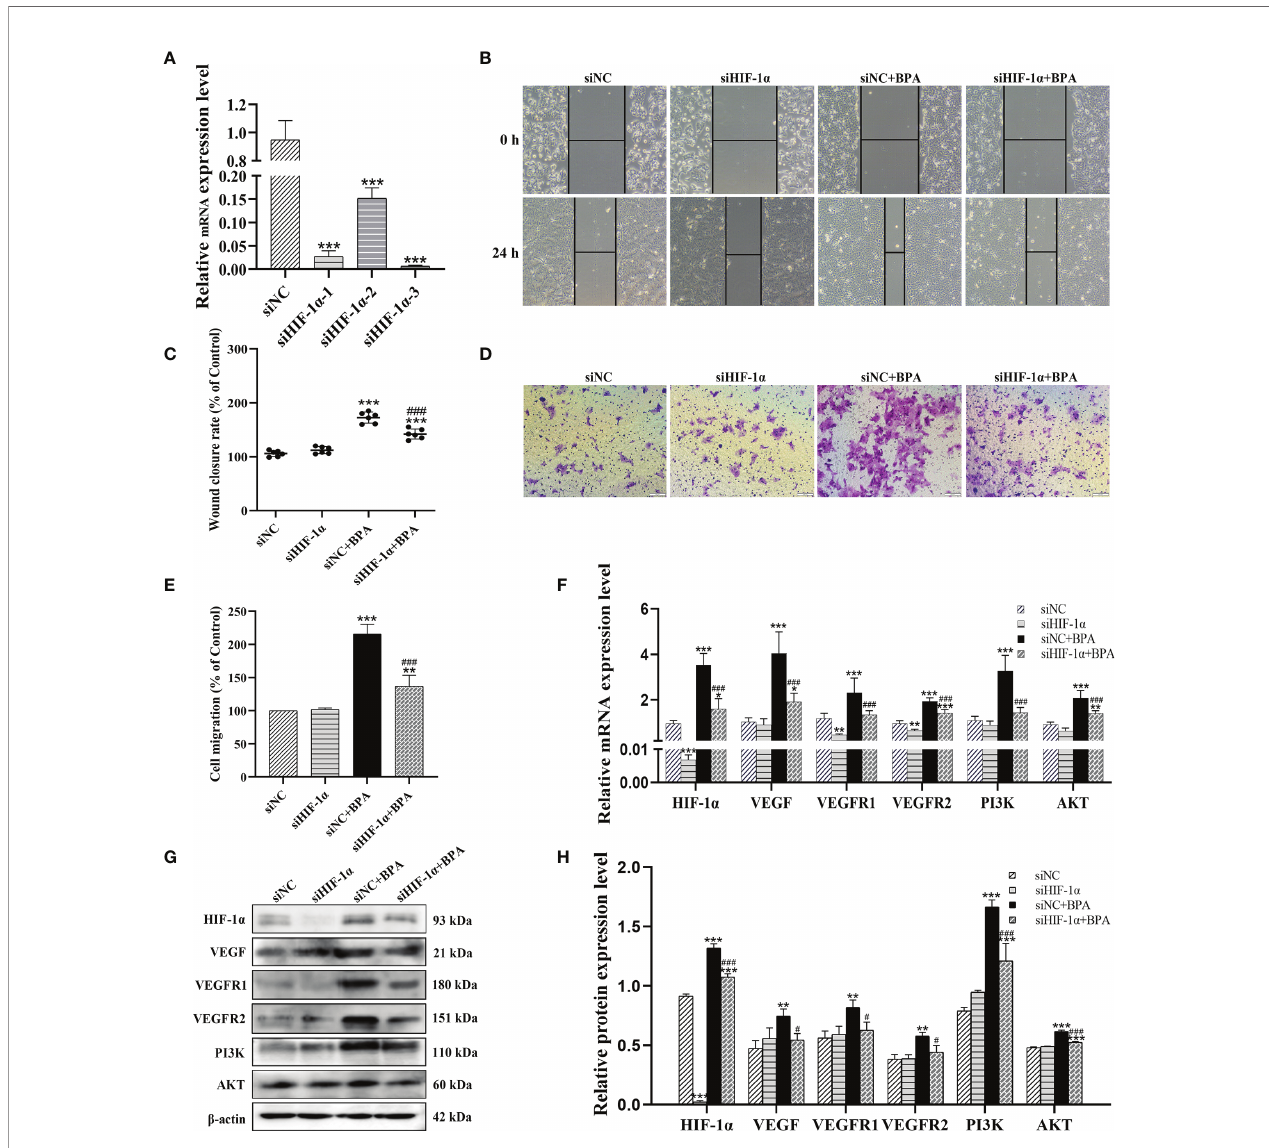
FIGURE 6 | HIF-1 a knockdown attenuated the BPA-induced increases in glycolysis, migration, invasion, HIF-1 a /VEGF and PI3K/AKT signaling pathway related biomarkers in DLD1 cells. (A) Results of qRT-PCR analysis of siHIF-1 a inhibition ef fi ciency in DLD1 cells after transfection for 24 h, n = 6. Representative pictures of cell migration (B) and invasion (D) . Quantitative analysis of cell migration (C) and invasion (E) rate, n = 6. The mRNA (F) and protein (G) expression of HIF-1 a /VEGF and PI3K/AKT signaling pathway-related biomarkers in DLD1 cells. (H) Quantitative analysis of protein expression associated with HIF-1 a /VEGF and PI3K/AKT signaling pathway by ImageJ Software, n = 3. Values are expressed as means ± SD, compared with the control group, * p < 0.05, ** p < 0.01, *** p < 0.001. Compared with the 1.00E-6 BPA group, # p < 0.05, ### p <